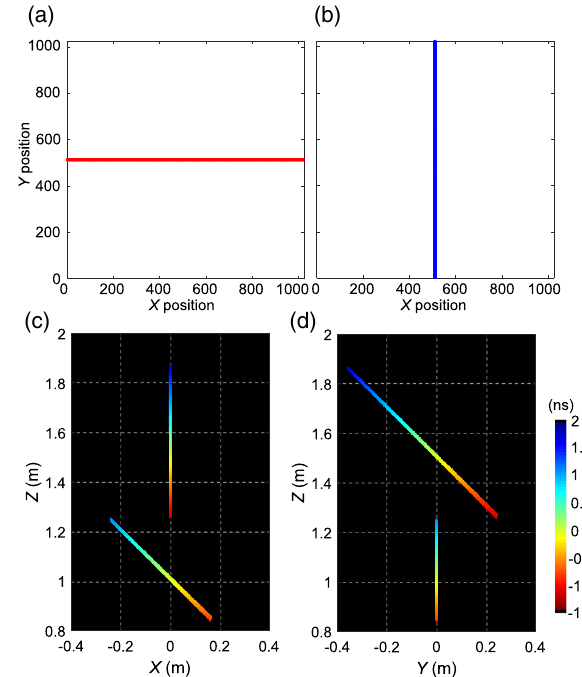
FIG. 7. Analysis of generated spatiotemporal data set. (a) Data points classified as the first data cluster based on 3D GMM. (b) Data points classified as the second data cluster. (c) Top view of reconstructed four-dimensional point cloud. (d) Side view of reconstructed four-dimensional point